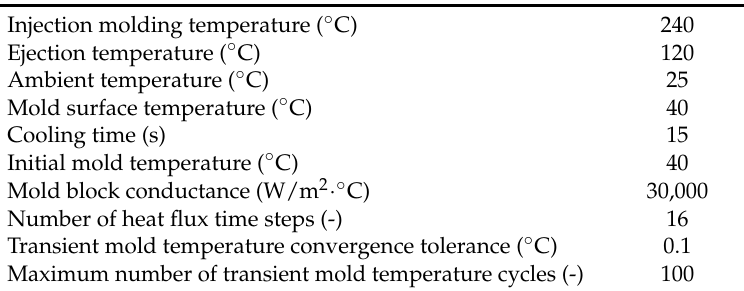
Table 1. The simulation parameters used in the study.